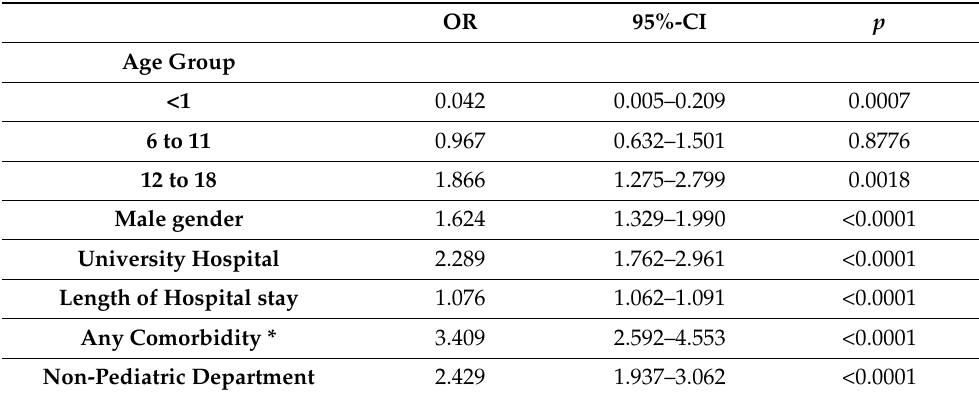
Table 7. Estimated odds ratio for use of CT vs. no CT.